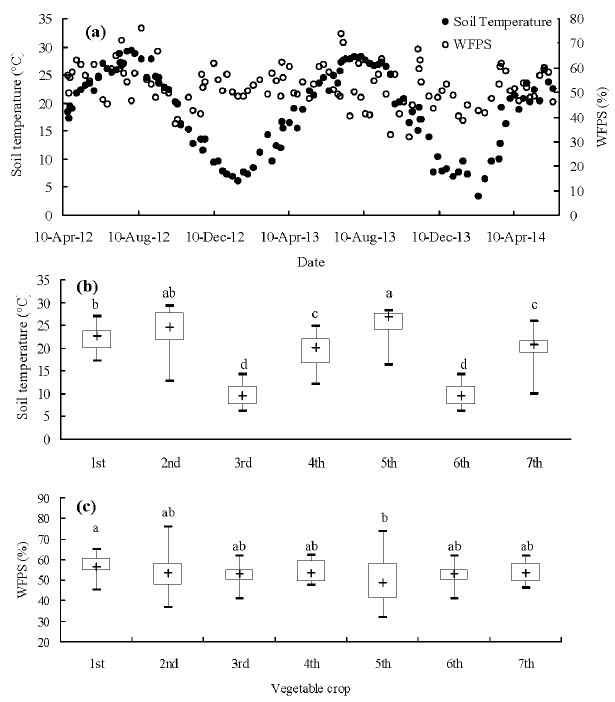
Figure 1. Dynamics of soil temperature ( T ) and WFPS across the experimental period (a) . Box plots for soil temperature (b) and WFPS (c) in different vegetable crops. The first to seventh mean different vegetable crops in rotation across the experimental period. Different letters indicate significant difference among all treatment medians ( p < 0.05). The plus mark in the box represents the medi- ans of all